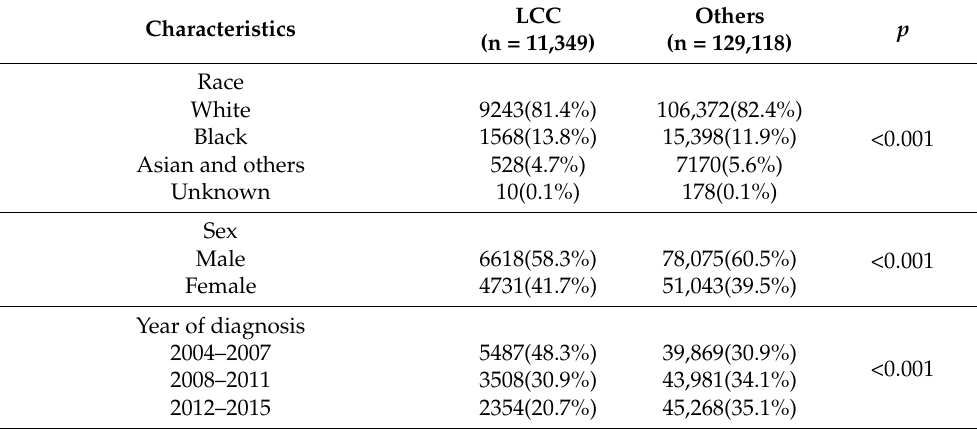
Table 1. Baseline characteristics of patients with LCC and other types of NSCLC before